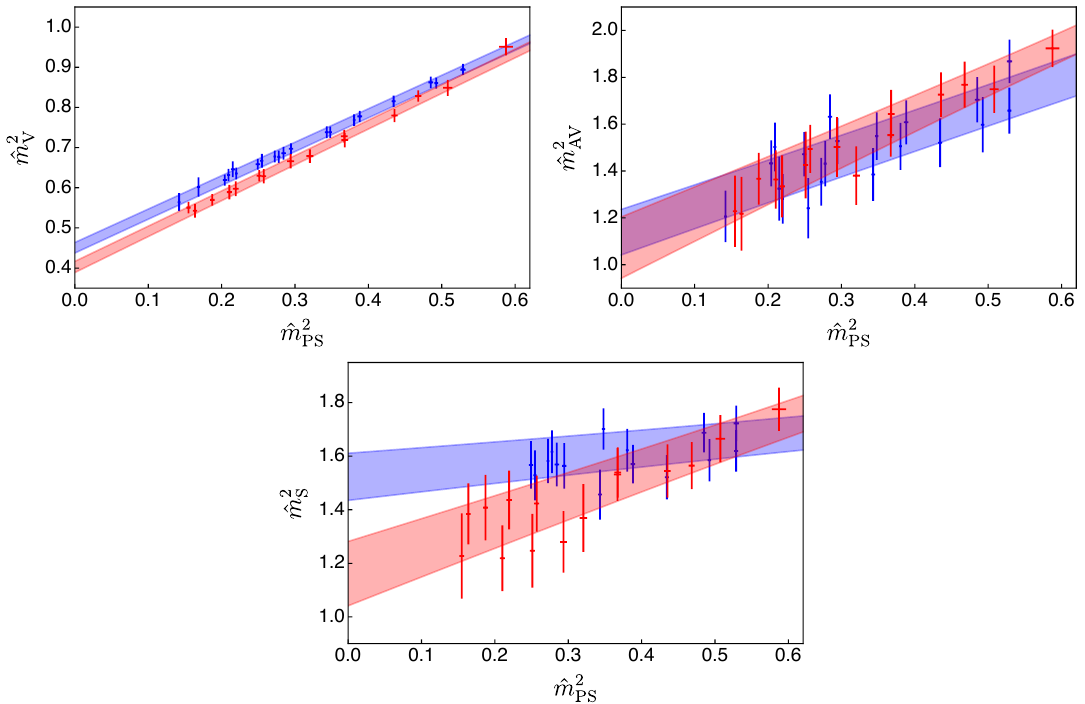
Figure 18. Meson masses squared from quenched (blue) and dynamical (red) calculations, in the continuum limit obtained by considering all the ensembles with ^ m 2 coloured bands illustrate the (cid:12)t of the measurements used in the massless extrapolations, with the width of the bands representing the statistical error in the